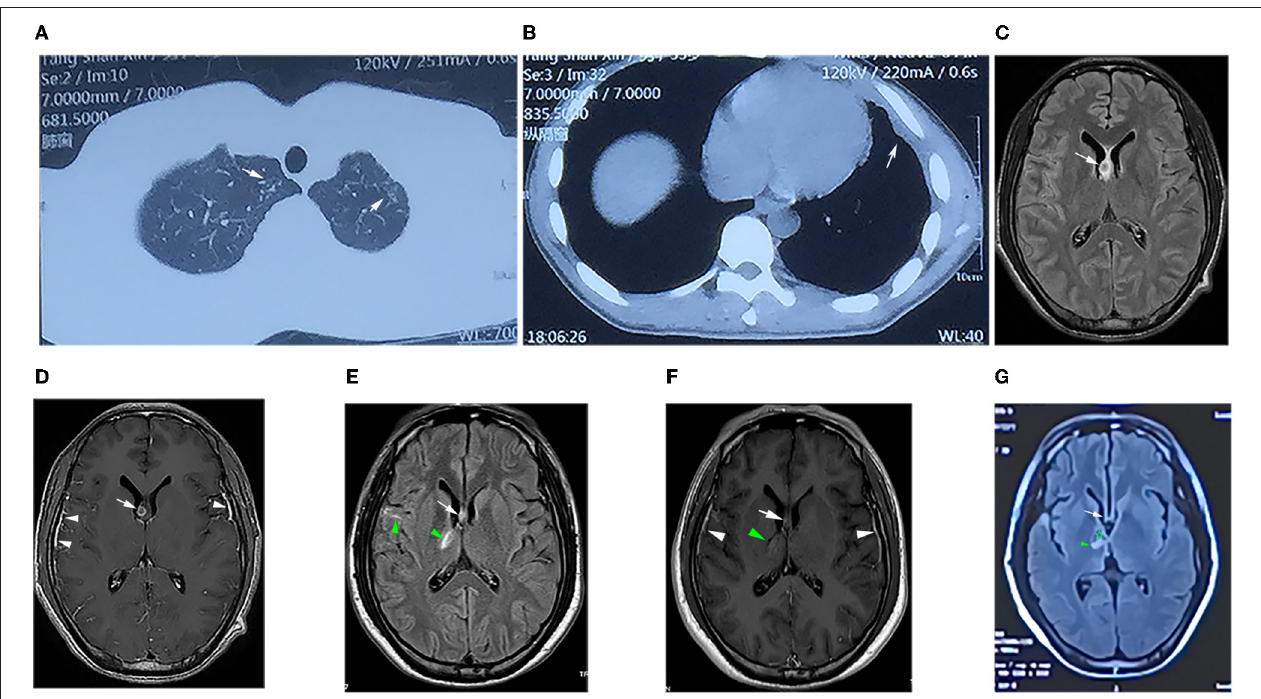
FIGURE 2 | (A) Computed tomography (CT) of the chest showing patchy high-density shadows in the upper lobes of both lungs (white arrow), suggesting secondary to tuberculosis. (B) CT scan revealed thickening of the left pleura and encapsulated effusion (white arrow). (C) T2-weighted magnetic resonance imaging (T2WI) FLAIR showing small circular isointense, slightly long hyperintense in the right lateral ventricle subependymal (white arrows). (D) Contrast-enhanced T1WI showing that the lesion was ring-enhancing (white arrows) and significant enhancement of the bilateral temporal leptomeningeal (white triangle). (E) T2WI FLAIR image showing that the right subependymal lesion (arrow) was smaller than that in (C) , and the right basal ganglia and right temporal lobe were patchy and line-like hyperintensity (green triangles). (F) Contrast-enhanced T1WI showing that the lesion in the right subependymal was smaller than that in (D) (white arrow), the lesion in the right basal ganglia was slightly enhanced (green triangle), and the meninges were thicker as before (white triangle). (G) T2WI FLAIR image showing that the subependymal lesion had basically disappeared (white arrow), the right basal ganglia lesion was slightly smaller (green triangle), and softening could be seen inside ( ☆